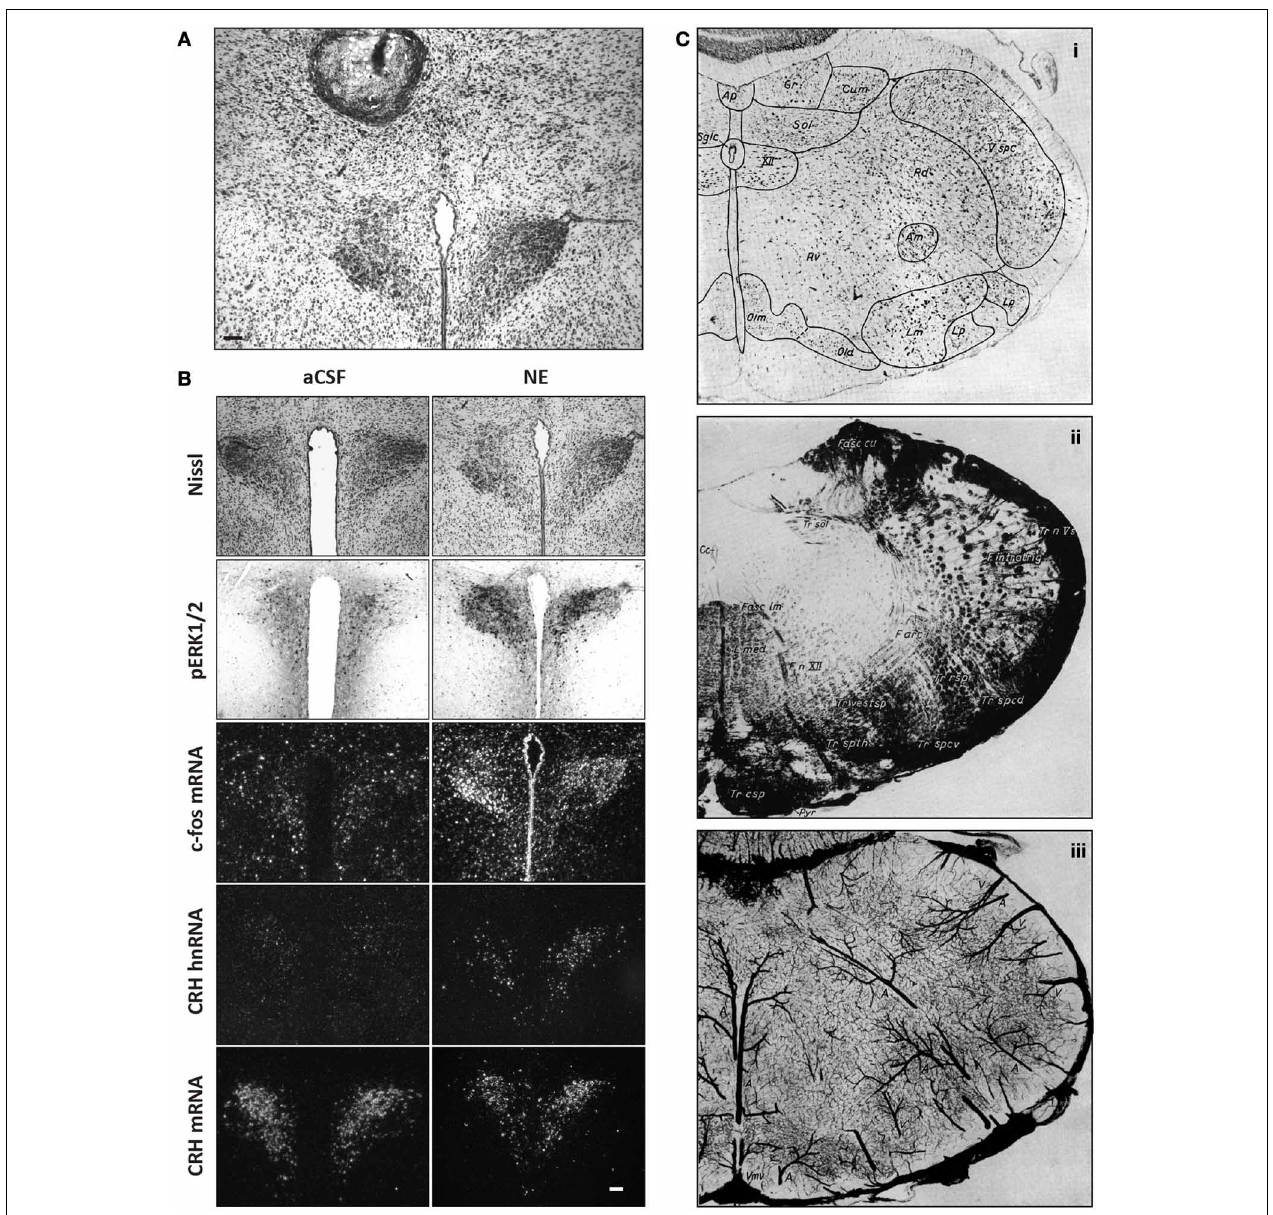
FIGURE 5 | Serial sections allow for intra-brain registration of multiple visualizable spaces. (A) Nissl-counterstained tissue showing the location of an injection site in the vicinity of the hypothalamic paraventricular nucleus, as published by Khan et al. (2007). (B) Effects of artificial cerebrospinal fluid (aCSF) injection (left column) or norepinephrine injection (right column) on activation of paraventricular hypothalamic neurons. The first row shows the structures in cytoarchitectonic space (Nissl stain). The second row shows the structures in functional space (the label is the